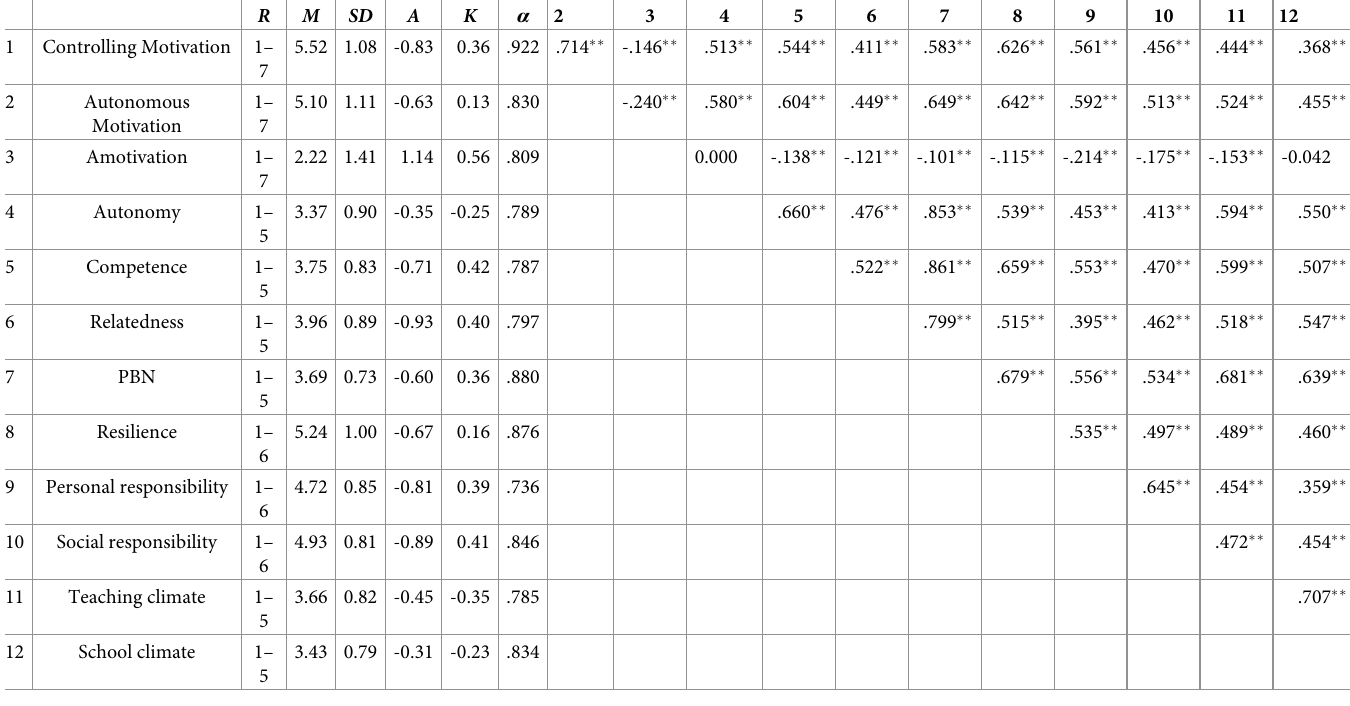
Table 1. Descriptive analysis and